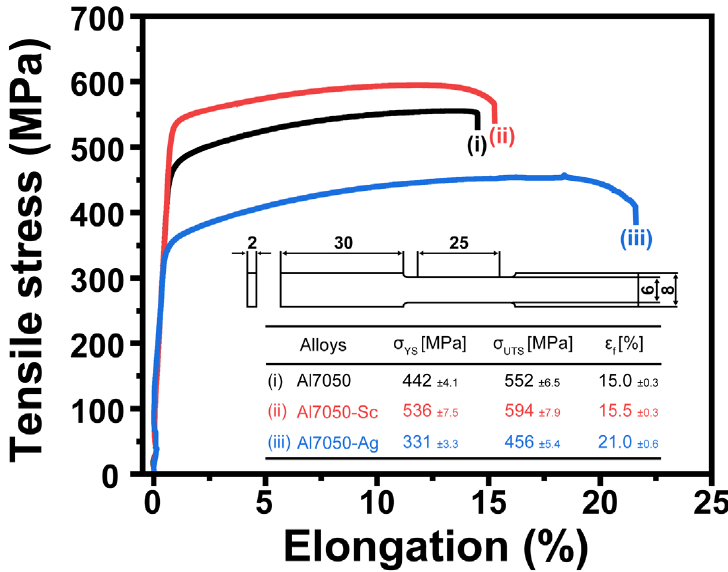
Figure 1. Tensile stress–strain curves obtained from T6-tempered (120 °C, 24 h) Al7050, Al7050-Sc, and Al7050-Ag alloys.